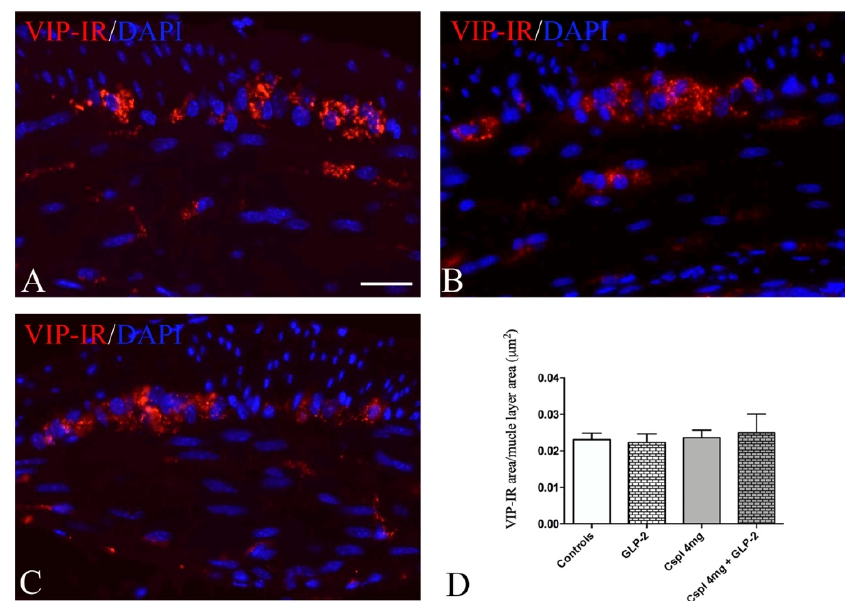
Figure 8. VIP labeling in muscle wall ( A – C ). Controls ( A ), cisplatin ( B ) and cisplatin + [Gly2]GLP-2 ( C ) group. VIP labeling was detected as small granules located within the ganglia and muscle layers. DAPI labeling stained the nucleus. Scale bar = 20 µ m. Quantitation of VIP-IR structures ( D ). The assessment of VIP expression was performed considering the whole cross-section. Data are expressed as mean ± SEM. One-way ANOVA test, post hoc Newman Keuls’. No significance. n = 4–6 for each group.